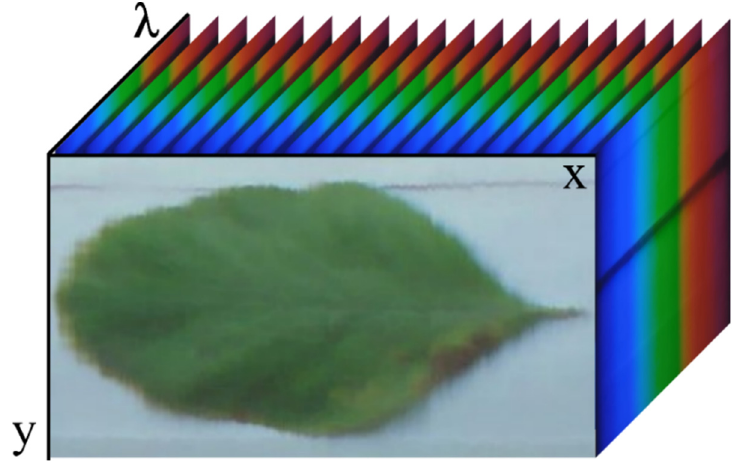
Figure 3. A visualisation of our hyperspectral data cube. The x and y axes correspond to pixel positions in the image with the λ axis corresponding to the hyperspectral plane.